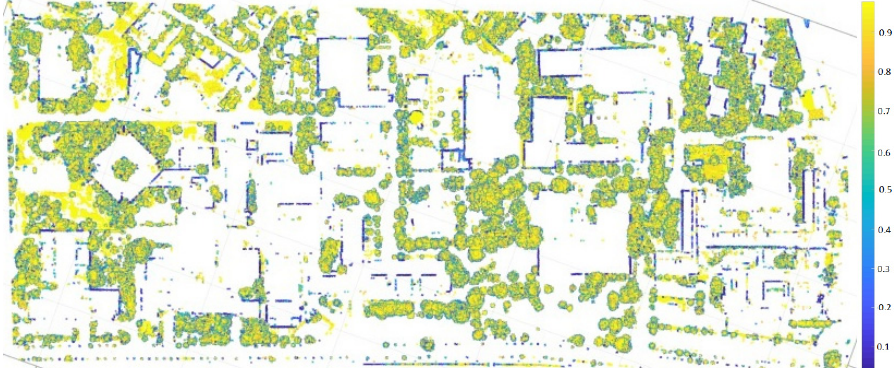
Figure 15. The filtered vegetation points colored by the normal vector component on Z axis.